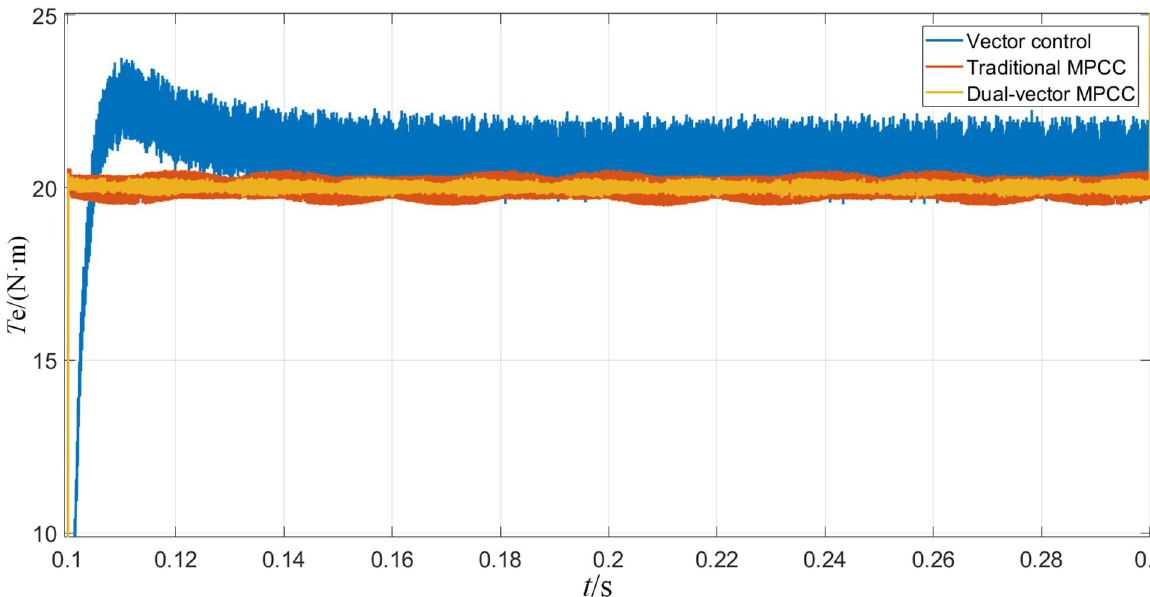
time and then decreases to the same level as the d-axis current. The shaft currents correspond- ing to both axes are similar, whereas the MPC maintains a shorter time and faster recovery. The simulation results corresponding to the sudden application of load torque to the PMSM are shown in Figs 10–12. In terms of speed, as shown in Fig 10, the speed under vector control suddenly drops to about 890 r/min and returns to a input speed in about 0.1 s. In con-